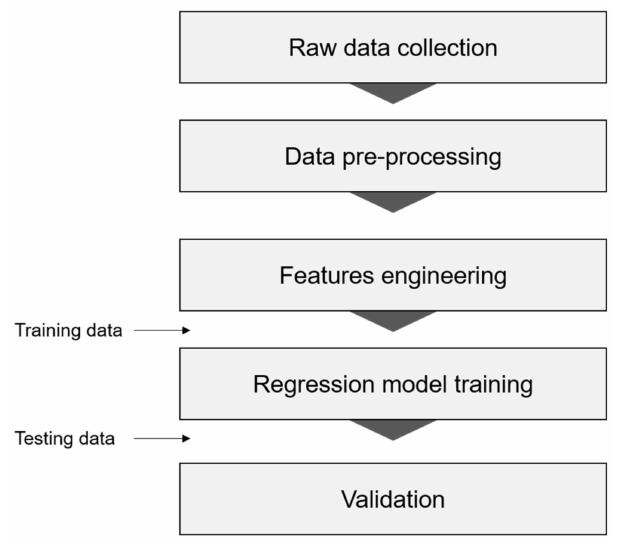
Figure 3. The framework for generating the ML-based regression